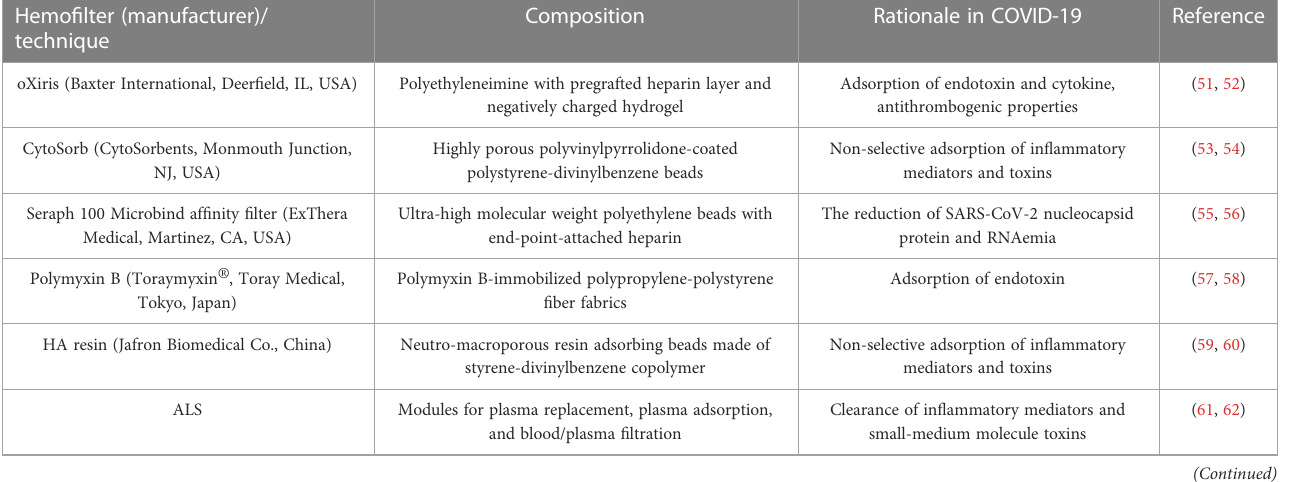
TABLE 1 Basic characteristics of currently available hemoadsorption therapy in COVID-19 patients. Hemo fi lter (manufacturer)/